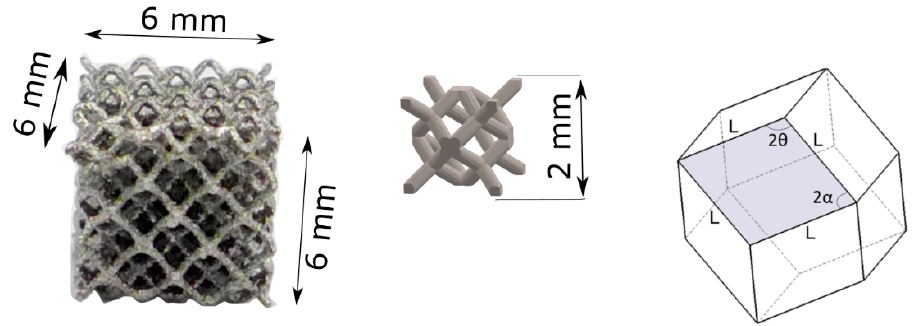
Figure 2. Compression specimen dimensions ( left ), a single unit cell dimensions ( middle ) and rhombic dodecahedron unit-cell ( right ).